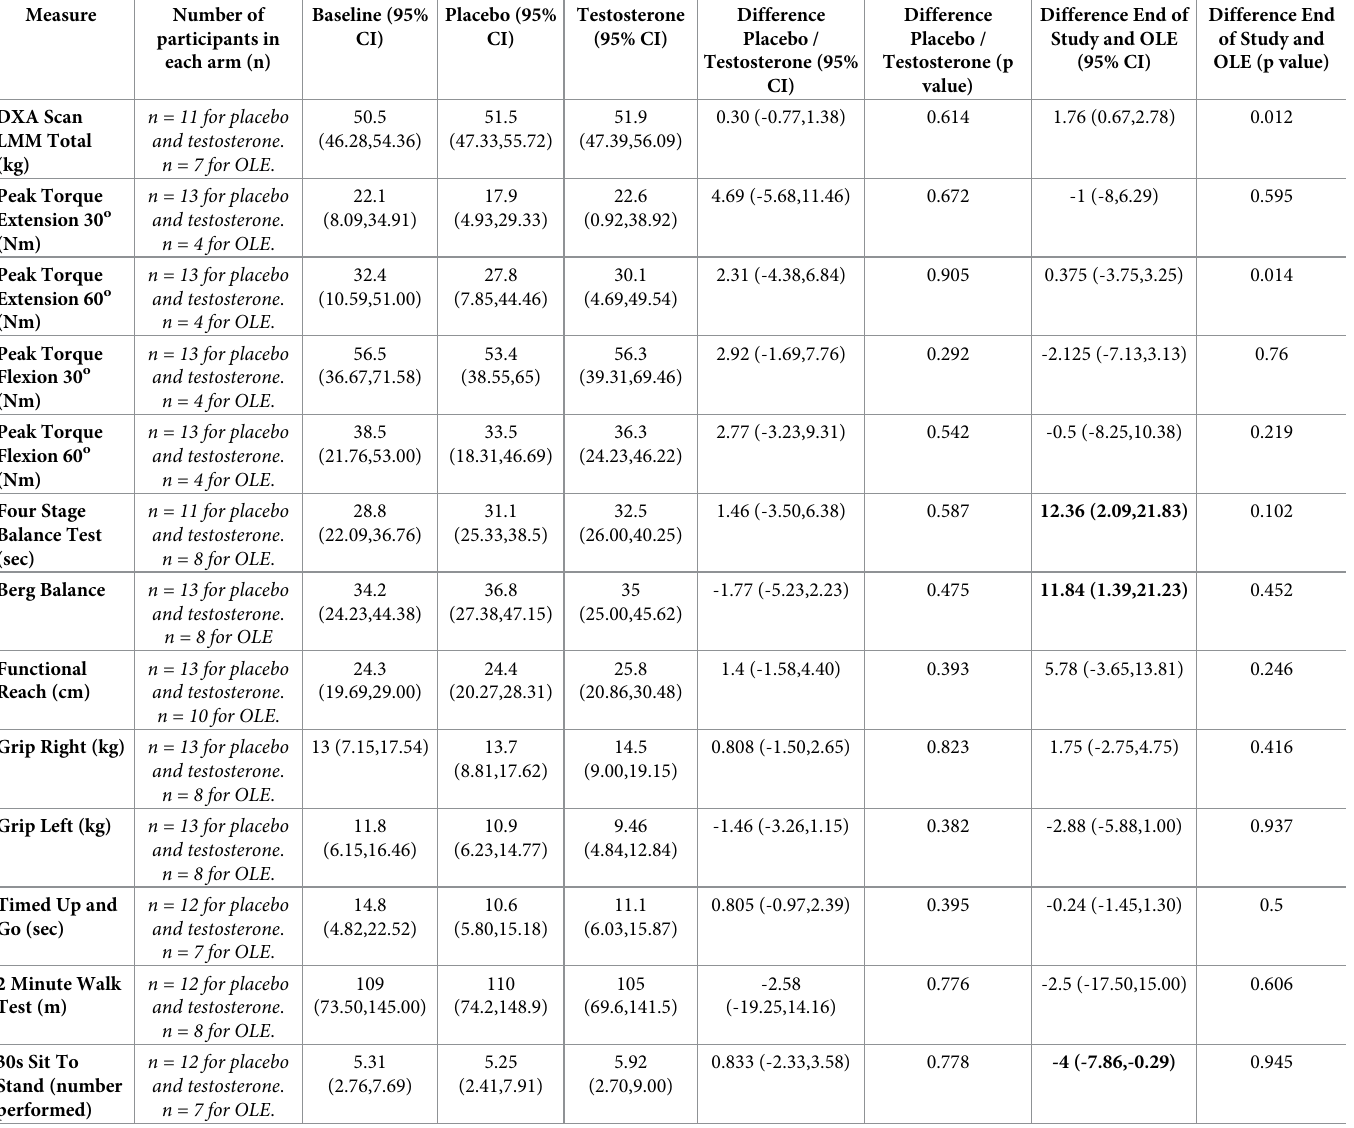
Table 2. Changes in outcome measures across placebo and testosterone arms and the open label extension arm.